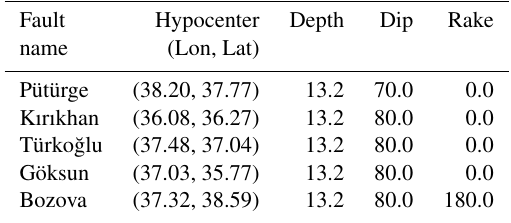
Table 1. Earthquake rupture input